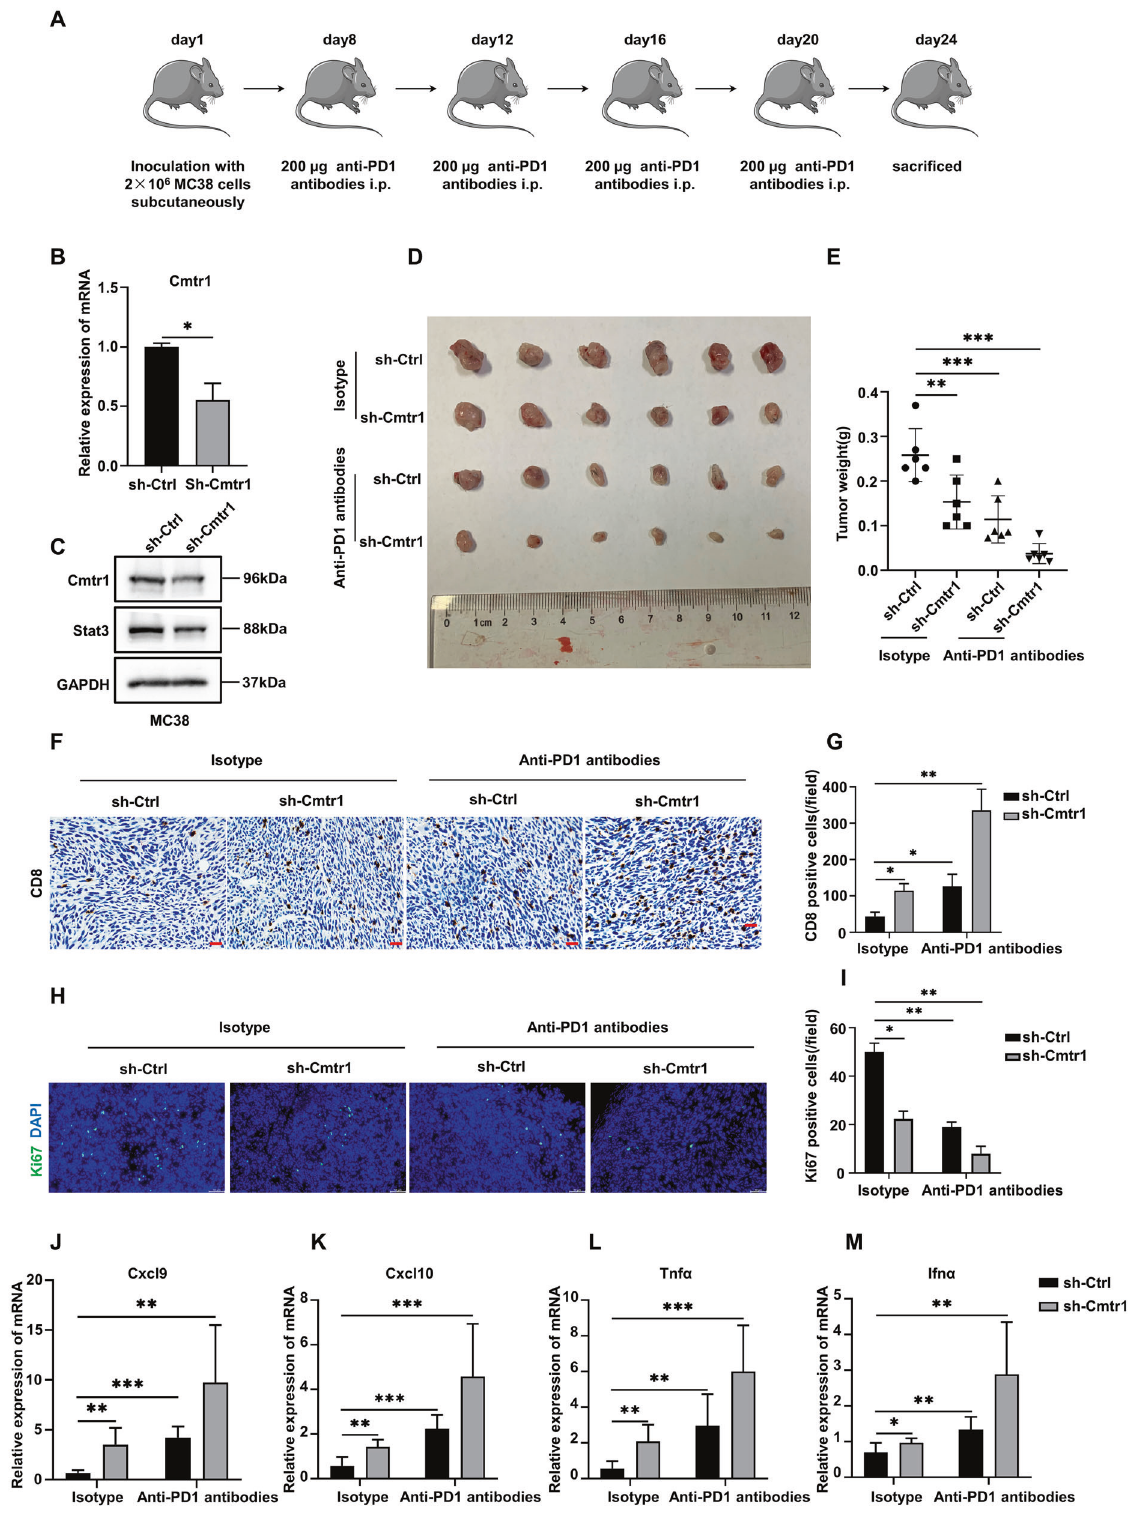
Fig. 6 CMTR1 knockdown enhances the ef fi cacy of PD1 blockade immunotherapy in colorectal cancer. A Schematic diagram showing the time point of anti-PD1 antibody treatment and analysis of tissues from C57BL/6 J mice implanted with MC38 cells. B , C After the knockdown of CMTR1 expression using shRNA, the expression of CMTR1 was measured by RT ‒ qPCR and western blotting. D , E Representative pictures of MC38 cell-derived tumors in C57BL/6 J mice, and tumor weights indicating the effects of CMTR1 knockdown or in combination with PD1. F , G Immunohistochemical staining and semi-quantitative analysis of CD8 positive T cells in tumors from mice indicating the effects of CMTR1 knockdown alone or in combination with PD1 blockade therapy. Scale bar: 50 µm. H , I Immuno fl uorescent staining and quanti fi cation of ki67 in tumors from mice upon CMTR1 knockdown or in combination with PD1. Scale bar: 50 µm. J – M Relative mRNA levels of in fl ammatory mediators in tumors from mice treated as indicated. * P < 0.05, ** P < 0.01, and *** P < 0.001. Cell Death and Disease (2023)